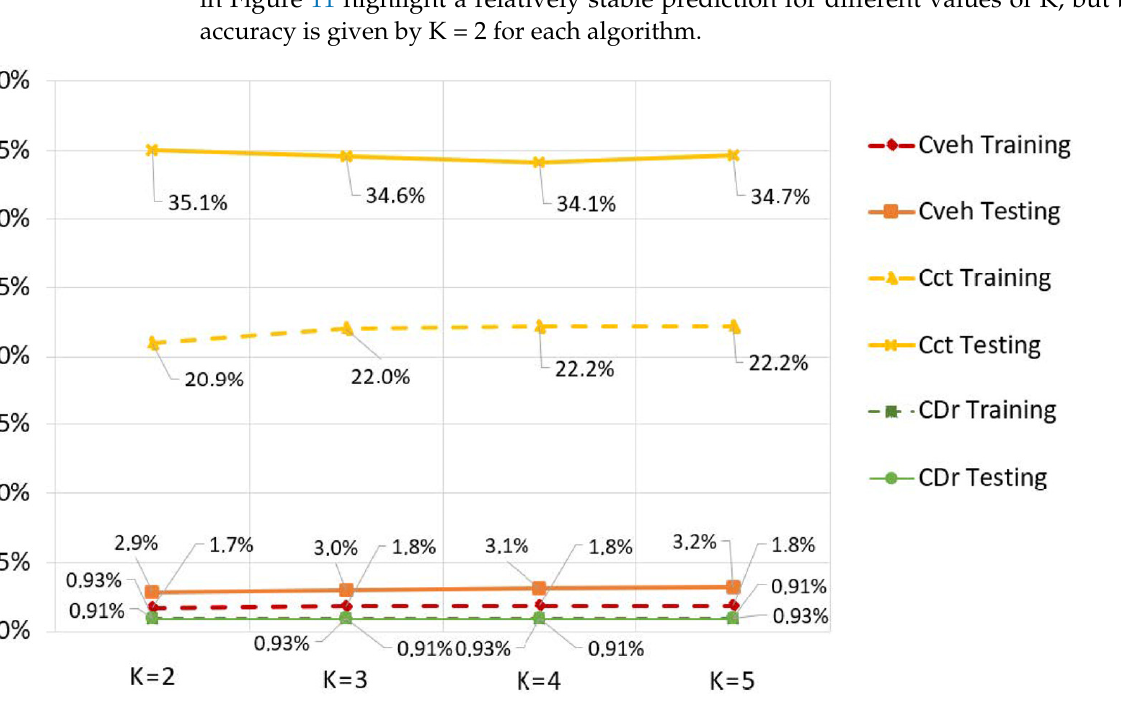
Figure 10. Predicted velocity vs. referent and real velocity.